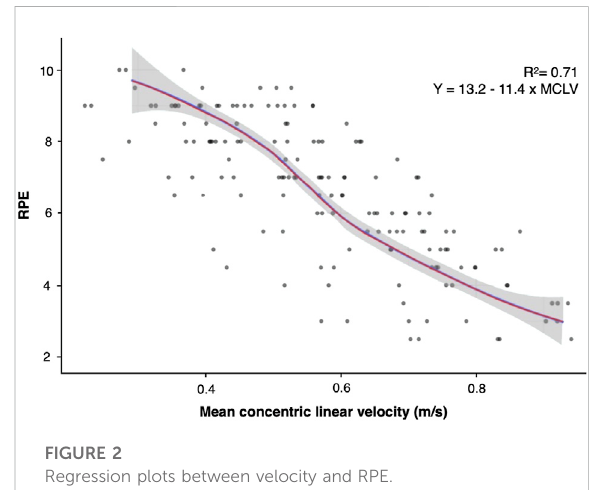
FIGURE 2 Regression plots between velocity and